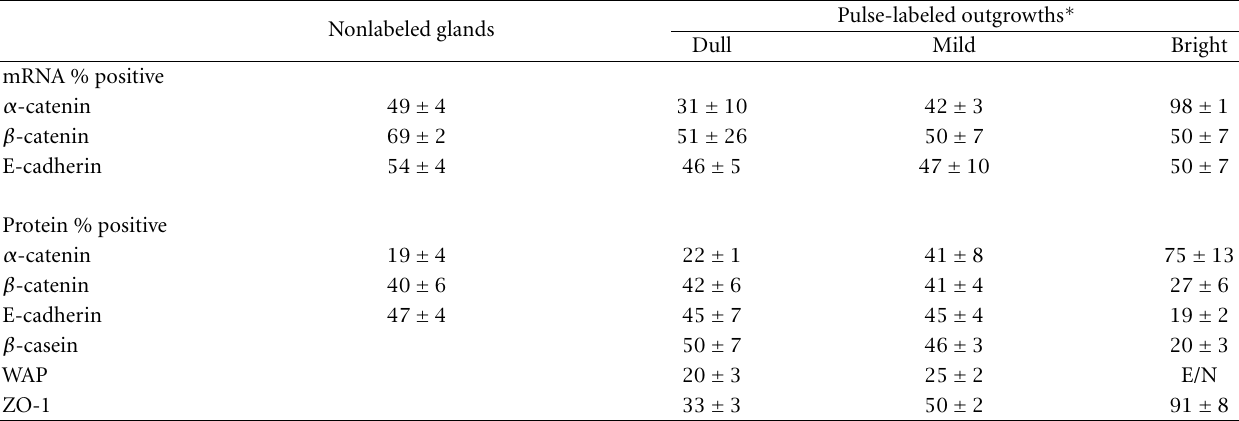
Table 1: Expression of cell-cell molecules located in nonlabeled or pulse-labeled mammary glands. Pulse-labeled outgrowths ∗ Nonlabeled glands Dull Mild